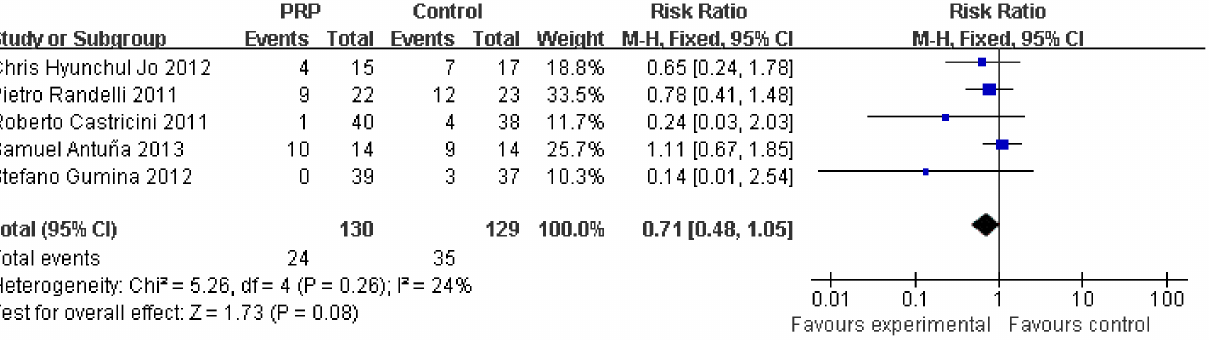
Figure 7. Difference in the rotator cuff retear rate.